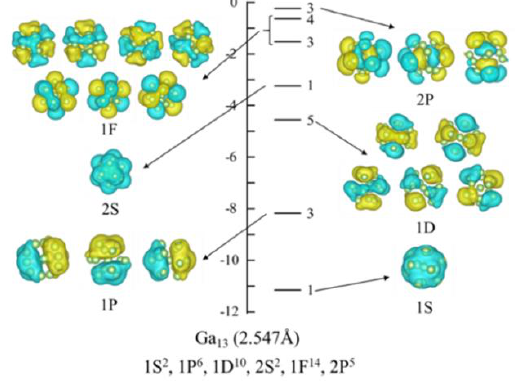
Figure 2. Energy levels and the wave functions of the superatomic orbitals of the superatom Ga 13 cluster (interatomic Ga – Ga bond distance is 2.547 Å ).